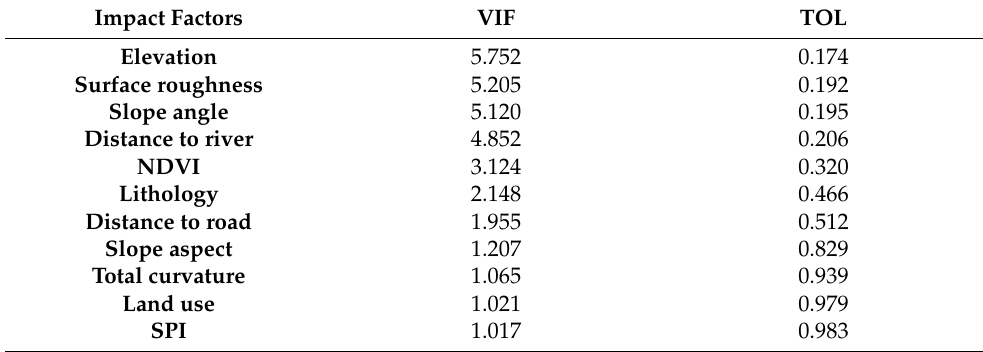
Table 3. Multicollinearity analysis result.